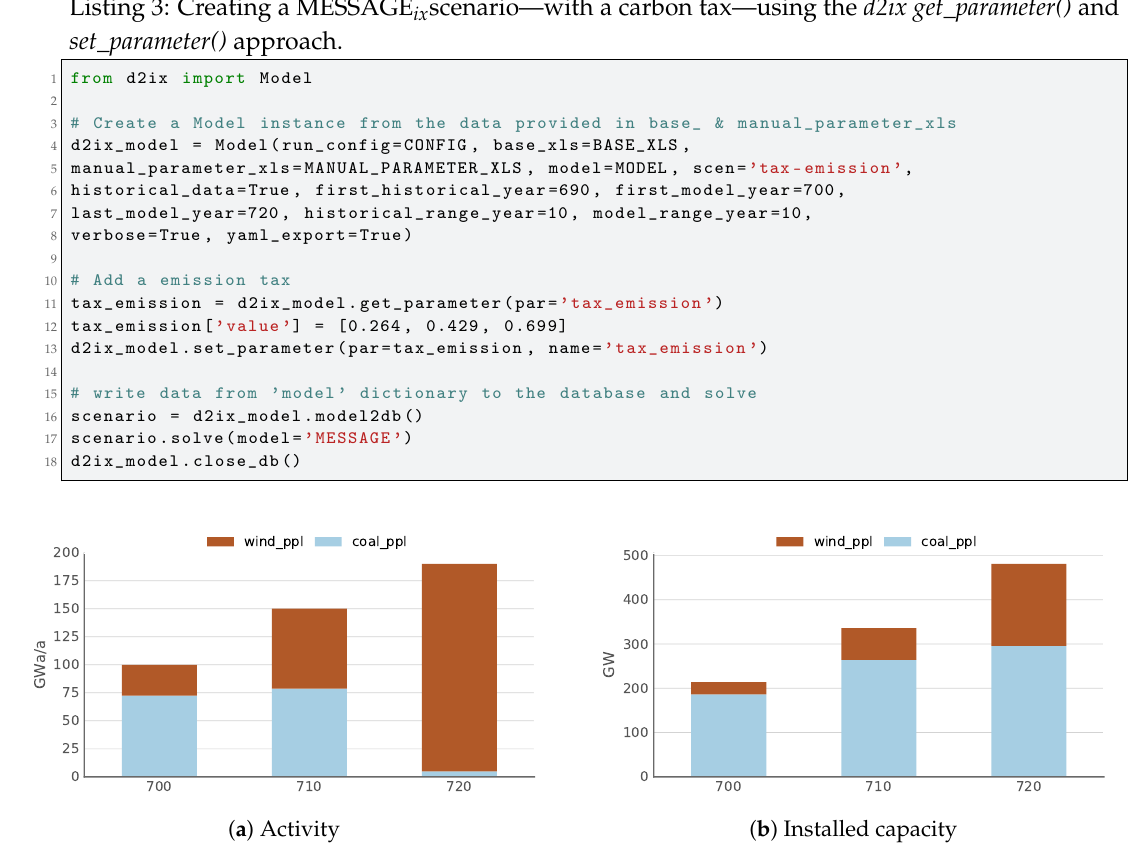
Figure 6. Power plant activity and capacity in the ‘tax-emission’ scenario (Listing 4).